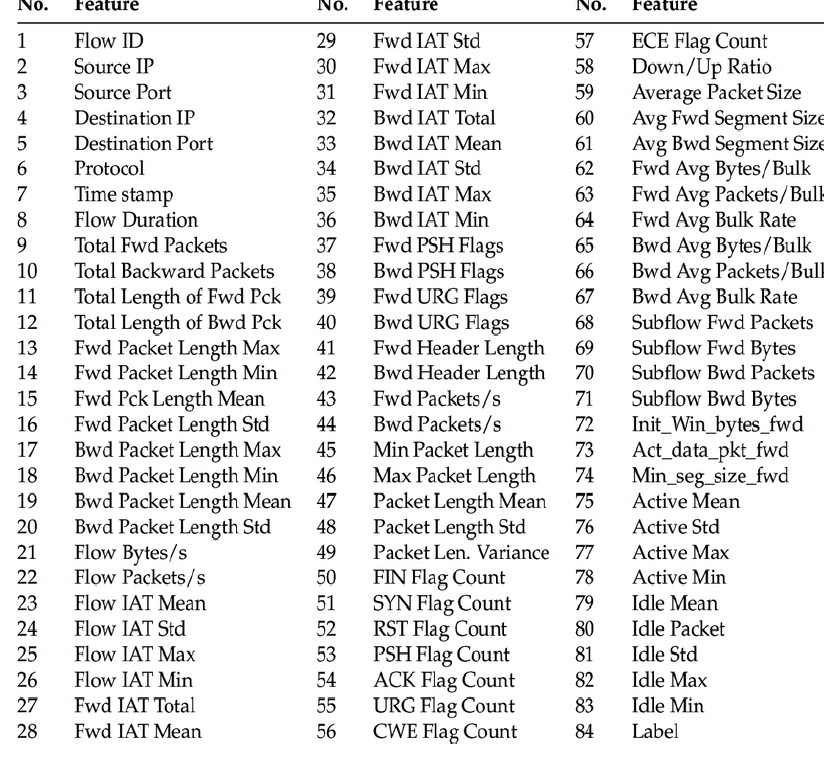
Figure 2. CICIDS2017 and CSE-CIC-IDS2018 network traffic features [67]. Complete form of the CICIDS2017 dataset that contains 3,119,345 instances and 83 attributes containing 15 class labels (1 normal + 14 attack labels). The prevalence of the majority class (Benign) is 83.34% and that of the minority class is 0.00039% (Heartbleed). CSE-CIC-IDS2018 was generated from a significantly bigger network of simulated client- targets and attack machines [7], yielding a dataset of 16,233,002 instances acquired from 10 days of network activity. Approximately 17% of the occurrences are assault